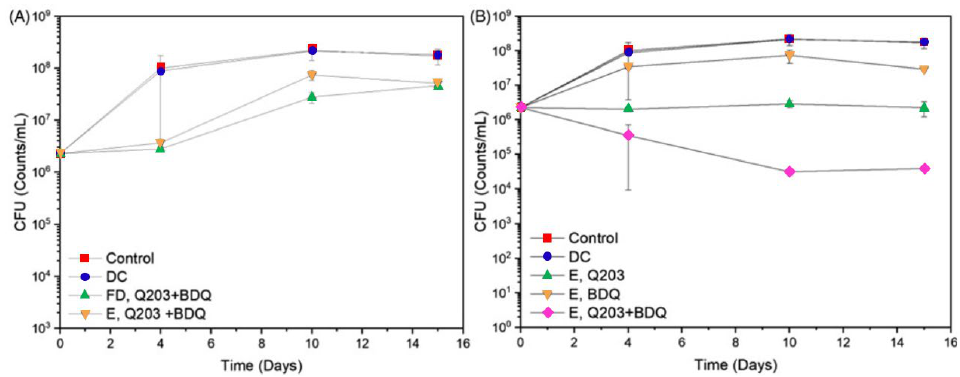
Figure 15. Effect of bedaquiline- (BDQ) and Q203-loaded polymeric nanoparticles (NPs) on bacillus Calmette–Guérin. The colony forming unit (CFU) count with respect to the incubation time is shown. ( A ) Comparison when drugs are free (FD) or encapsulated (E). ( B ) Comparison when drugs are encapsulated (E) separately or together. DC: drug carrier (empty NPs). Adapted from reference [145], used under Creative Commons BY 4.0 license.